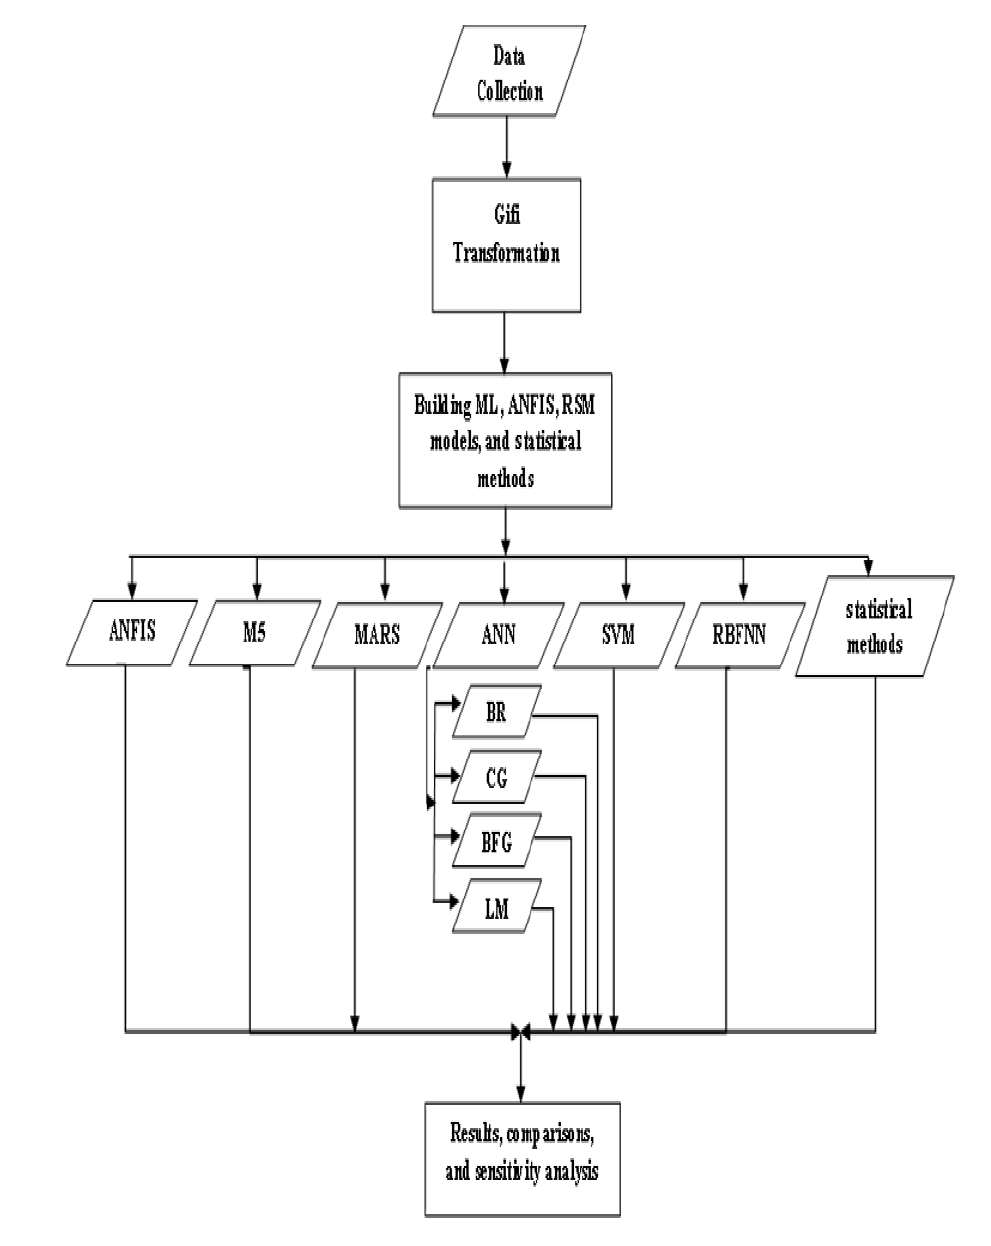
Figure 3. Flowchart of machine learning approaches for the prediction of cardiovascular diseases; see abbreviations in